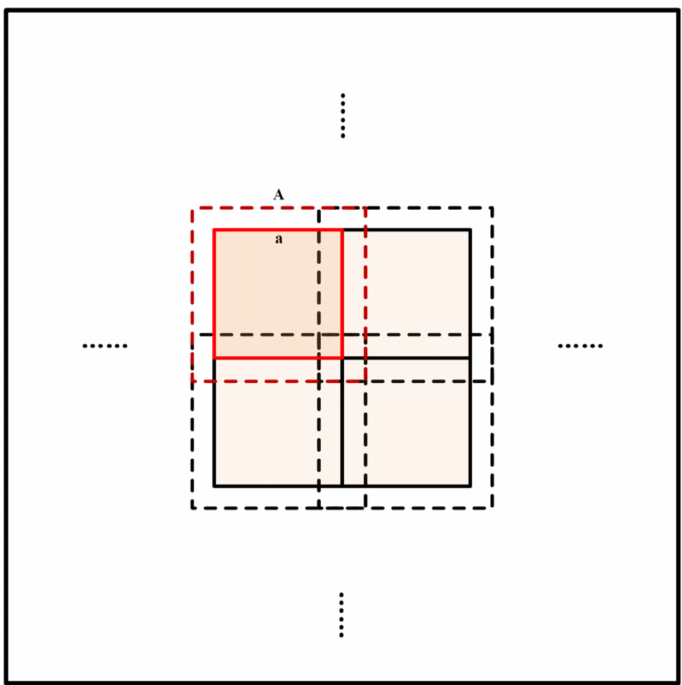
Figure 13. The strategy of edge-ignoring